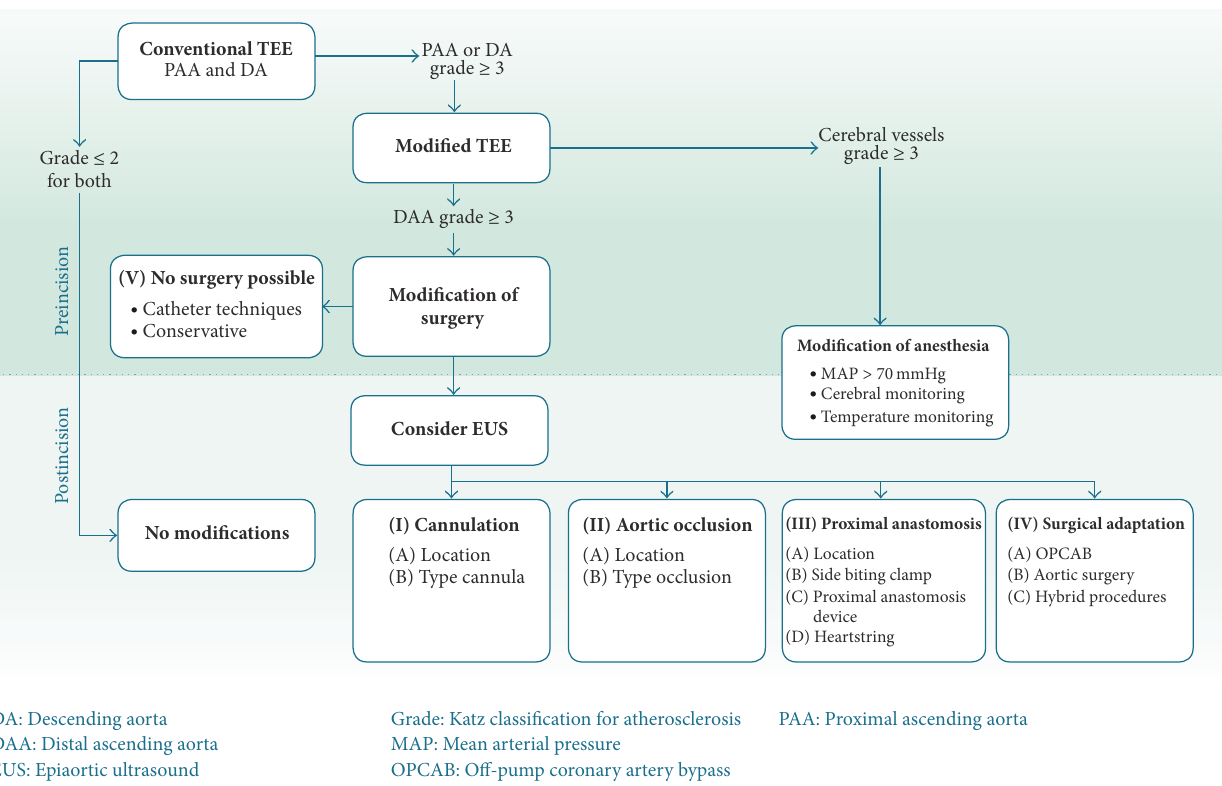
Figure 1: Flowchart of the diagnostic and therapeutic management of aortic atherosclerosis in cardiac